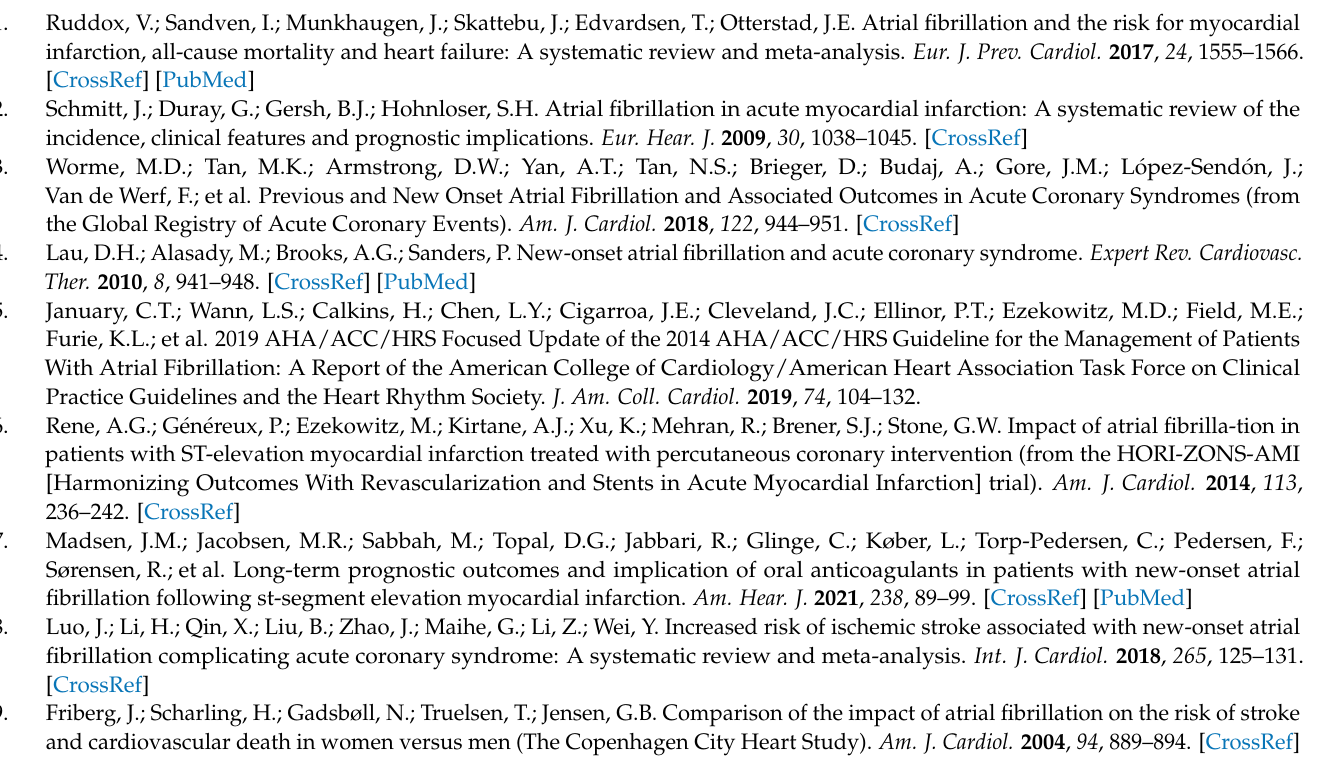
Table S3: characteristics according to onset time of AF in men ( n = 7327). Table S4: characteristics according to onset time of AF in women ( n =